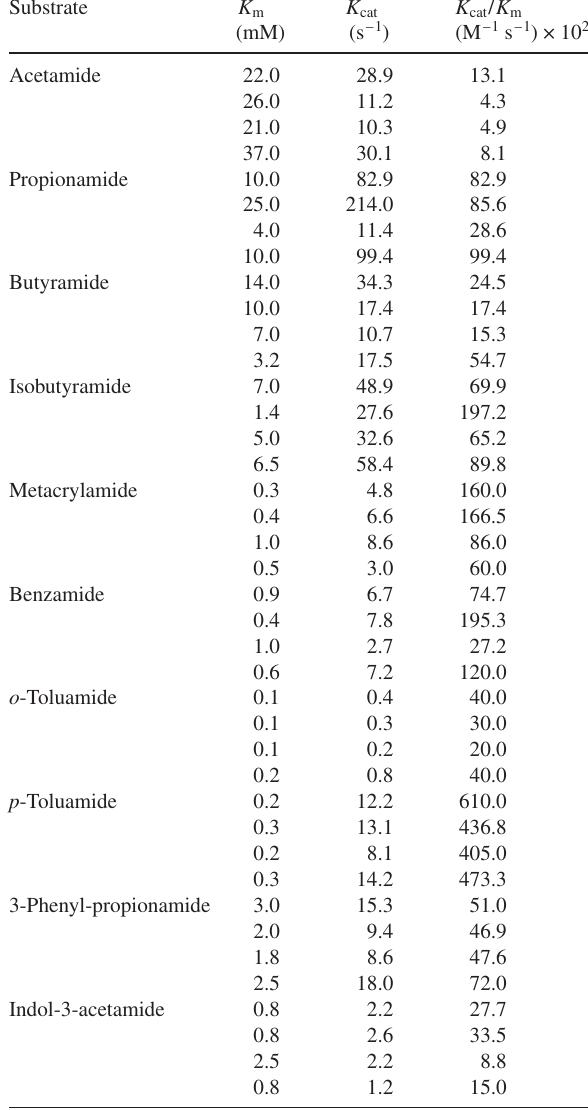
Table 6. Kinetic properties of Sulfolobus solfataricus WT amidase (1strow), mutant T319I (2nd row), L34P (3rd row), Y41C (4th row). The turnover number ( k cat ) was obtained by dividing by the molecular massof the monomer(55,784 Da); temperaturewas 70 °C; 1–10 µg of enzyme was present in a totalvolume of 200 µl; incubationtimeswere 2–10 min in 50 mM citrate buffer pH 5.0. Values reported are repre- sentative from at least three independent experiments with different lots of enzymes. Abbreviation: K m = Michaelis constant.